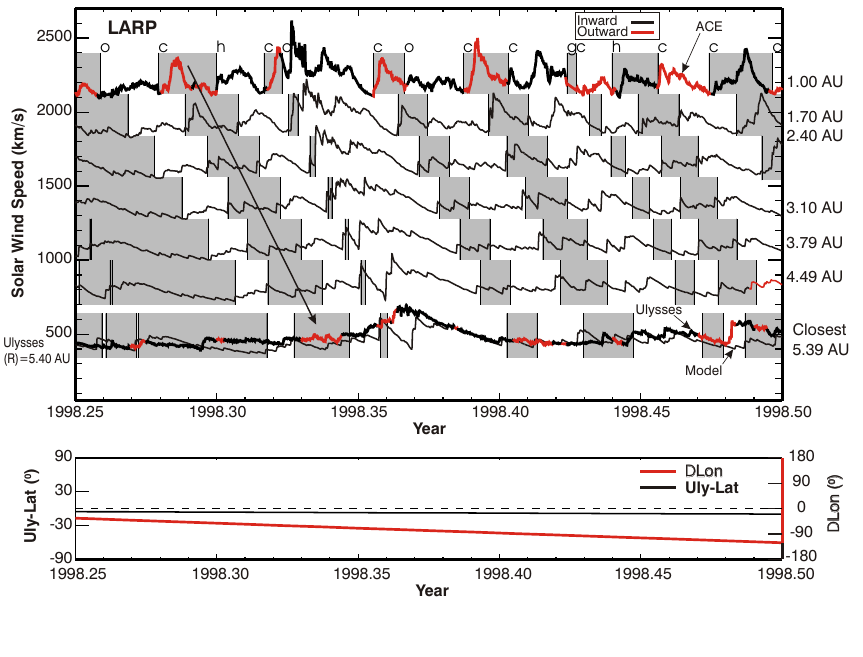
Fig. 6. Same data as in Fig. 1, but now the common source longitude ad- justment has been included. The data is divided into regions with vertical bars. These points are then kept track of with in the simulation as they propagate out- ward. Alternating grey and white shows how regions propagate. The arrow shows how one of the region propagates from 1AU out 5.4AU. Above each re- gion is a label indicating the classifica- tion. O for other, c for ICME, h for high-speed stream, and g for data gap. For the ACE and Ulysses curves, red is outward sector, and black is inward.